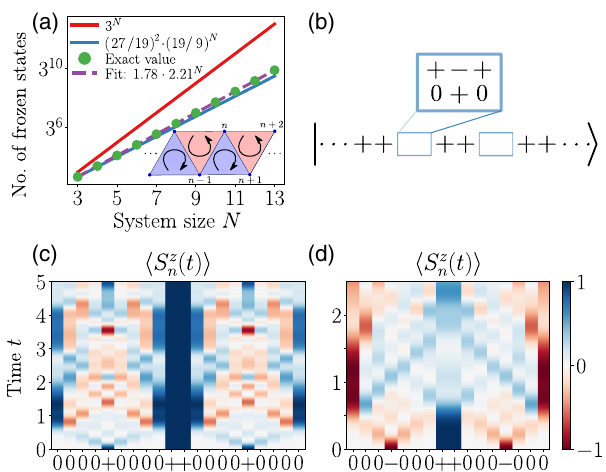
FIG. 2. Fragmentation of the Hilbert space into smaller sub- spaces. (a) Exponential scaling of frozen states, which correspond to invariant subspaces of dimension D ¼ 1 , and comparison to the Pauling estimate. (b) Example of higher-dimensional sectors, in the form of spatially separated two-level “ bubbles. ” (c),(d) Time-evolved charge density h S z n ð t Þi for the two initial states indicated under each figure. (c) The þþ block in the middle cuts the system in half when ( þ ) fractons are placed on each side. (d) When they are replaced by ( − ) fractons, the block melts and the two halves become